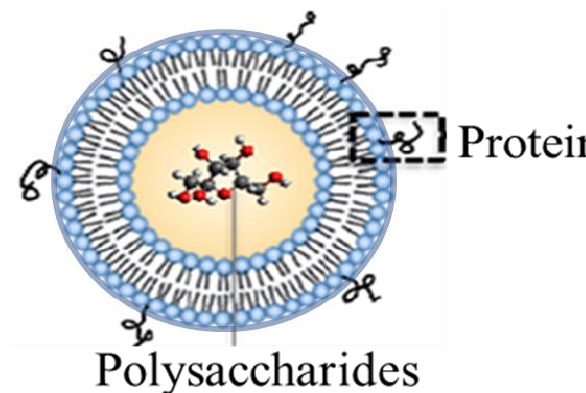
Figure 1. Dual-antigen delivery liposomal vaccine carrier featuring encapsulated polysaccharides and surface-attached proteins.